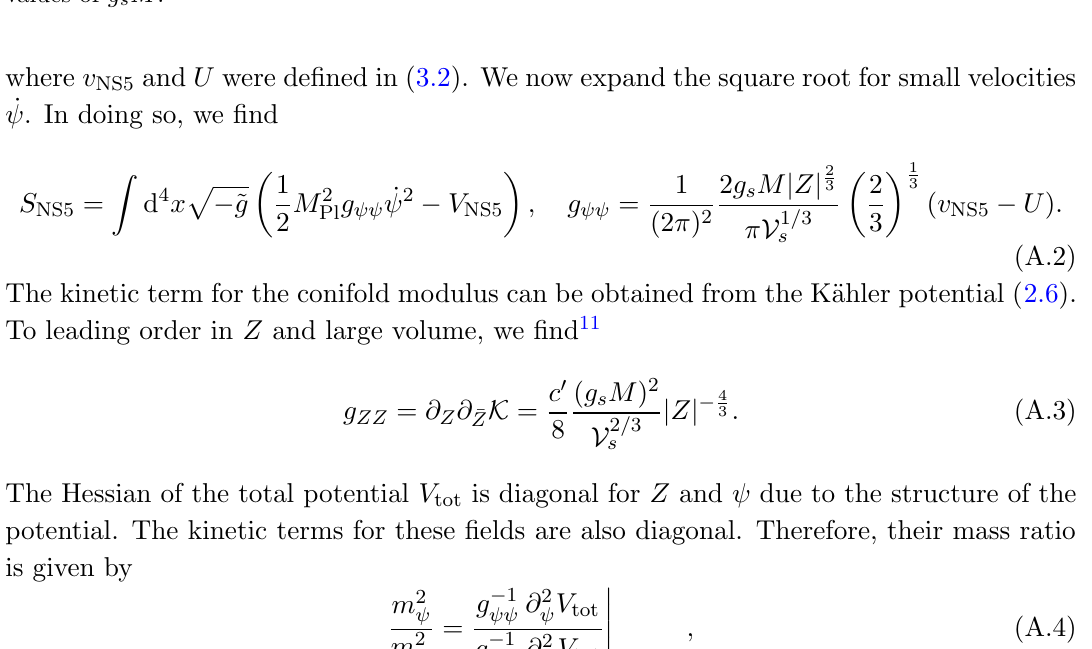
0 : 08. The mass ratio is thus (cid:25)